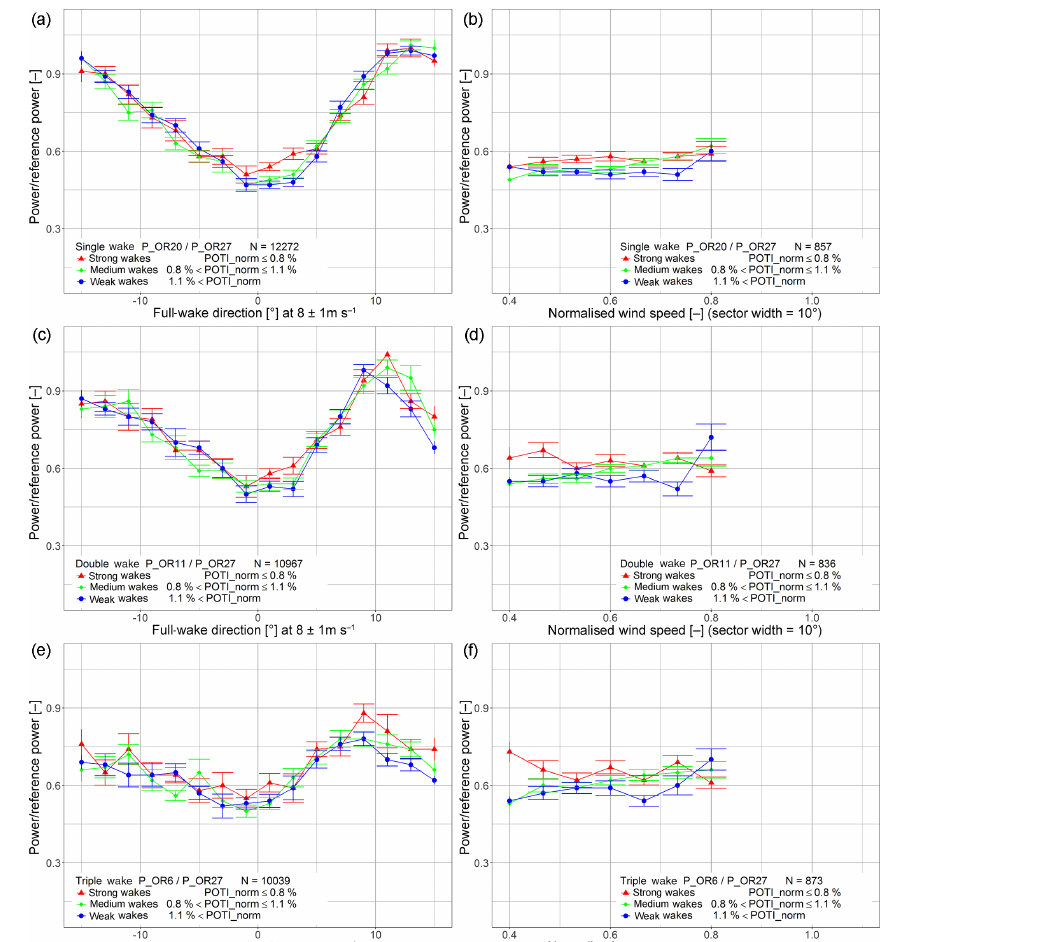
Figure 19. Wake effects in Ormonde (OR) under different conditions. Power of downstream turbine normalised with free-flow turbine. First row: single wake, second row: double wake and third row: triple wake. Left column: normalised power as a function of wind direction, right column: normalised power as a function of wind